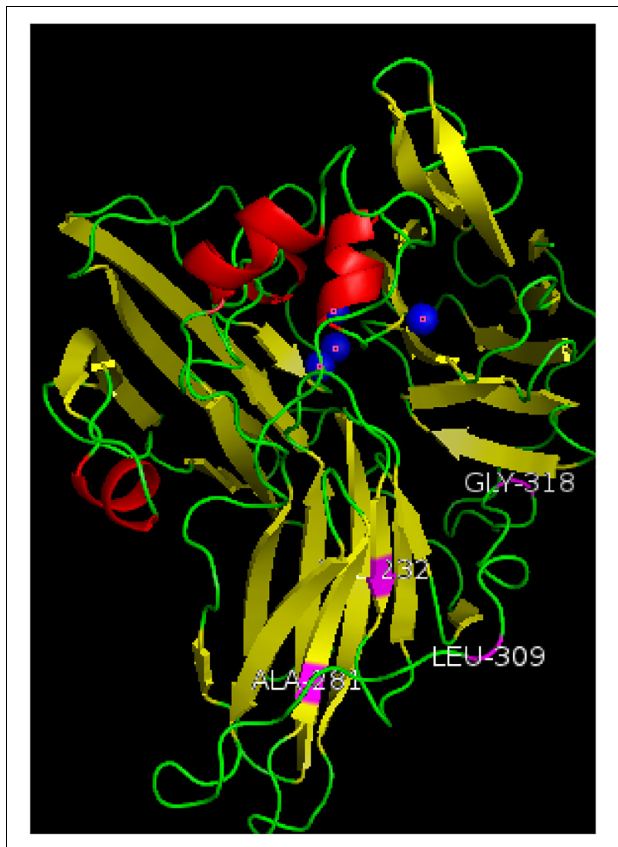
FIGURE 5 | Three-dimensional structure simulation diagram of mutant enzyme lac2-9. α -Helixes (red), β -sheets (yellow), loops (green) and copper atoms (blue) are depicted. The mutation sites of the mutant enzyme (shown in purple in the Figure 5 ) V281A, P309L, S318G, and D232V are far away from the active center of laccase, and are located on the surface or ring region of the laccase protein. Among them, 309 and 318 are on the loop of the spherical structure, and 281 and 232 are on the α